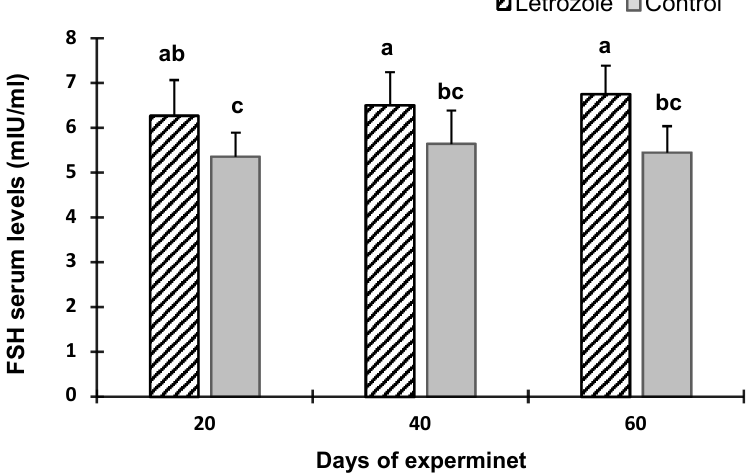
462 Figure 5. Follicle-stimulating hormone (FSH) levels in Markhoz bucks treated letrozole (0.25 mg/kg BW/wk) or control. Error bars indicate stand- ard deviation. a,b Statistically significant differences (p<0.05) between the groups. Figure 5. FSH levels in Markhoz bucks treated letrozole (0.25 mg/kg BW/week) or control. Error bars 463 indicate standard deviation. Statistically significant differences (p<0.05) between the groups. 464